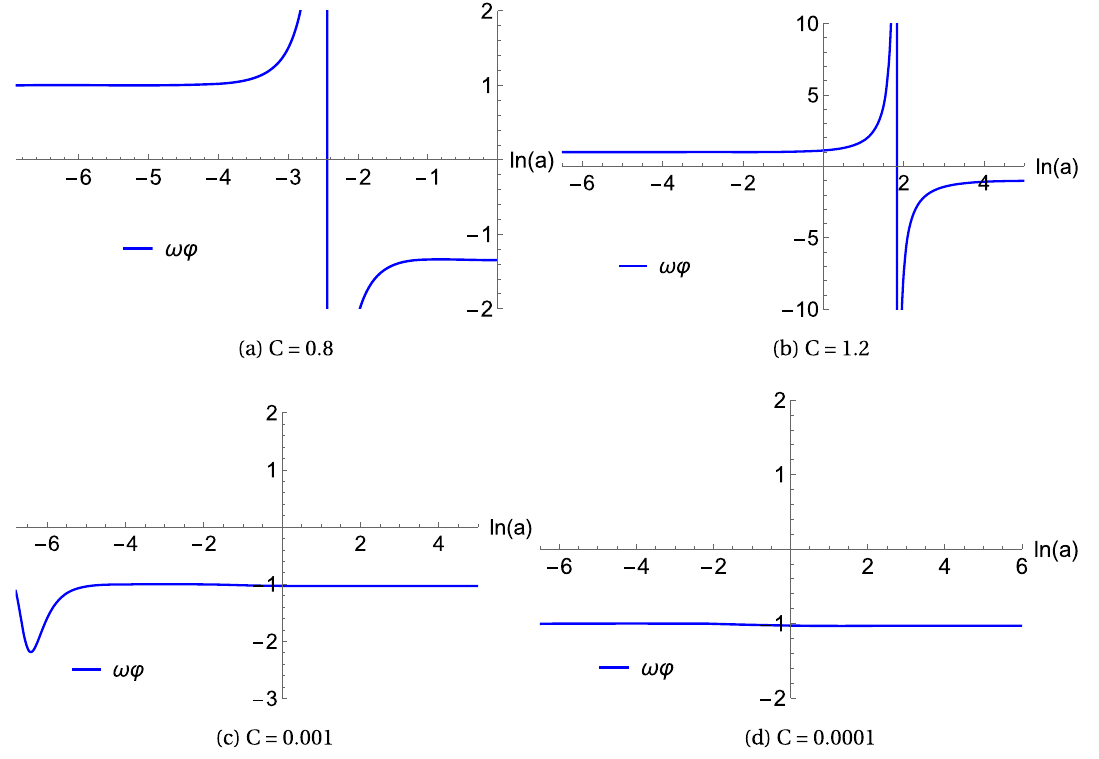
Fig. 7 The qualitative behaviour of the DE equation of state ( ω φ ) parameter for different values of coupling constant (C)